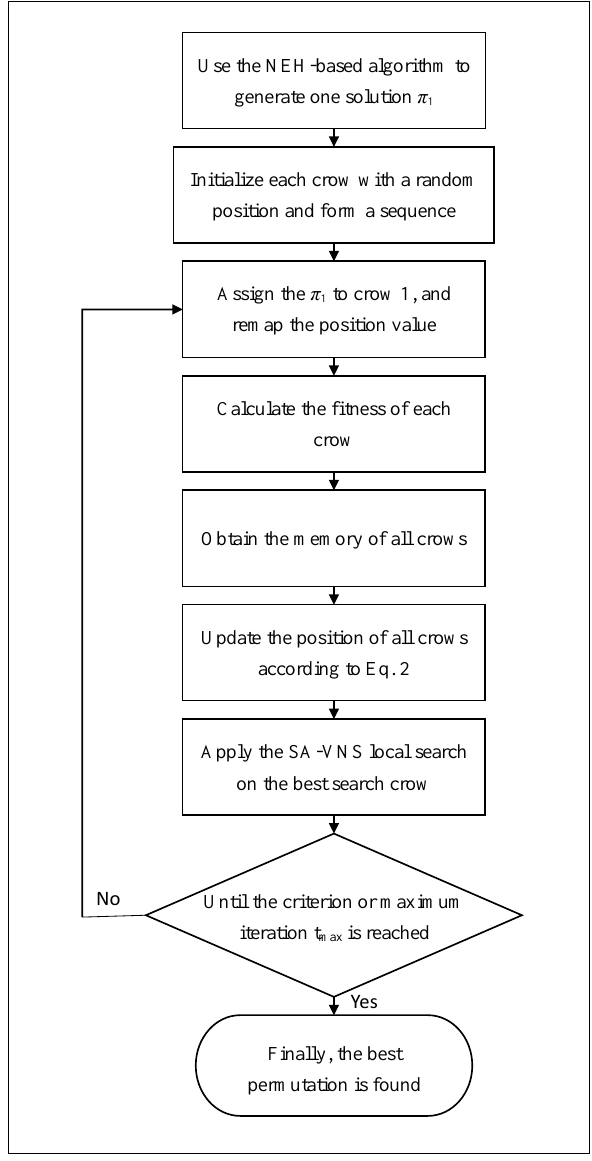
Figure 2. Proposed hybrid CSA (HCSA) for solving the permutation flow shop scheduling problem